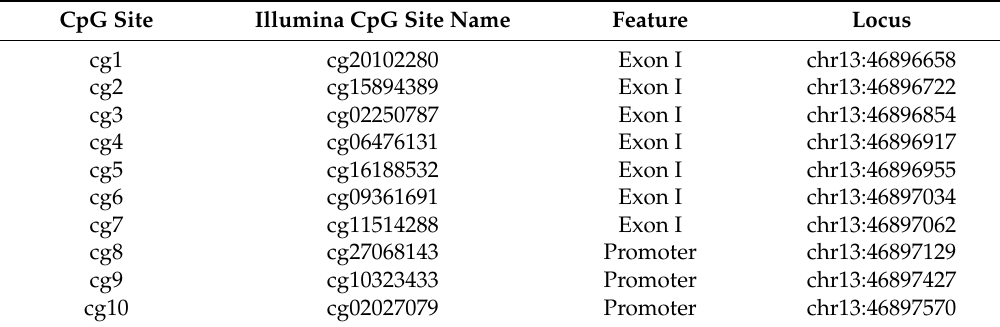
Table 2. Details of selected CpG sites.